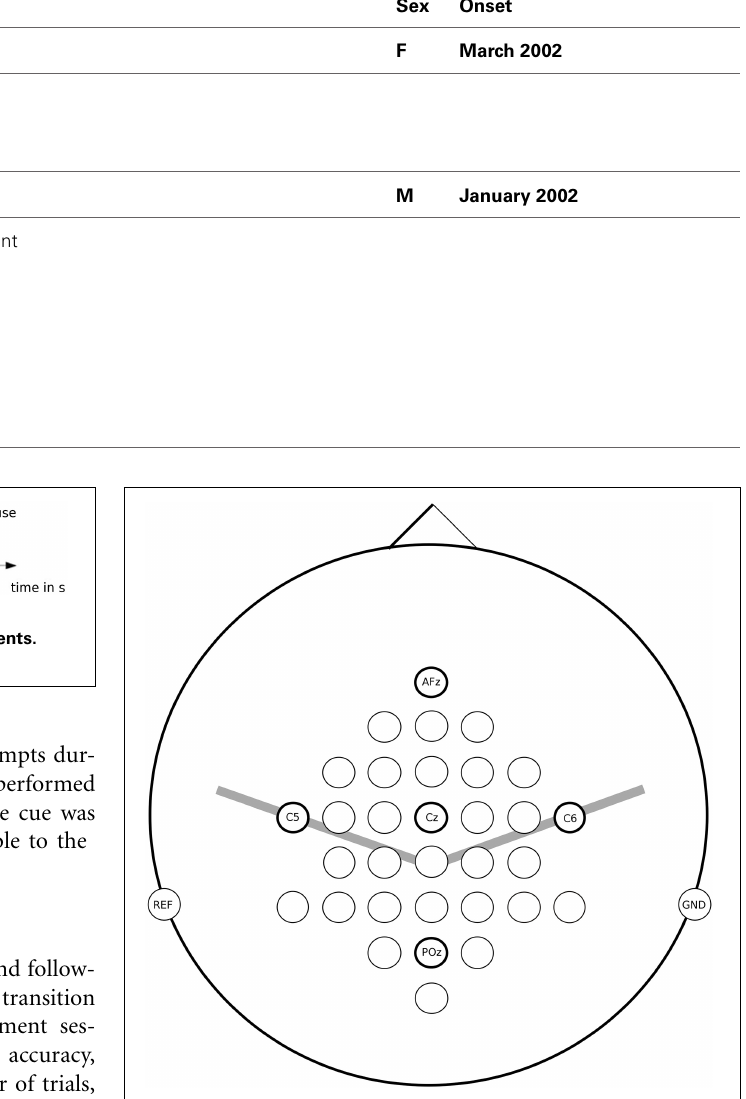
FIGURE 2 | EEG channel locations used for measurements in